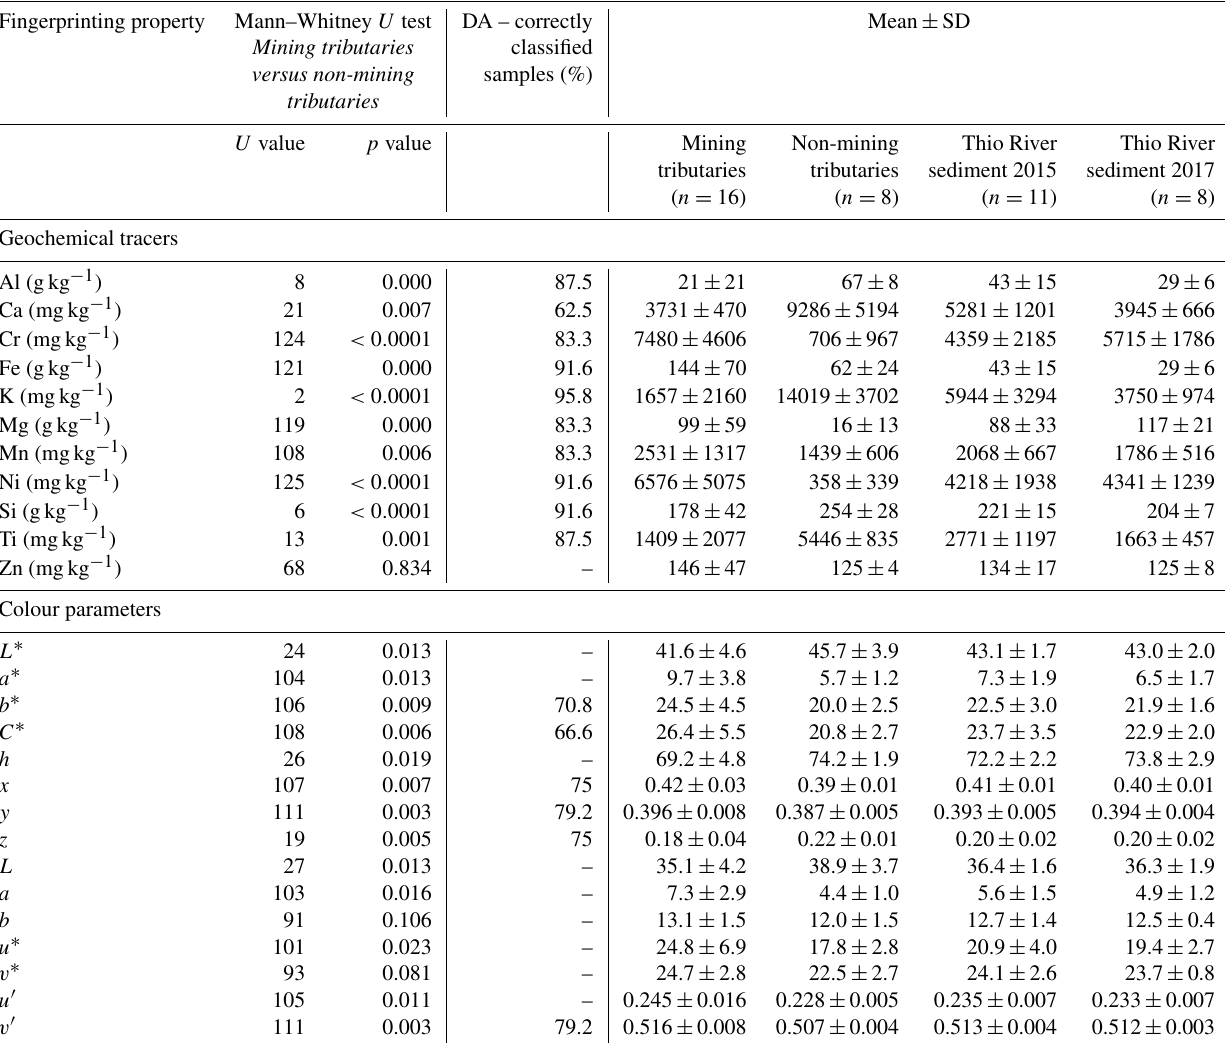
Table 2. Mean values of geochemical element contents and colour parameters in the < 63µm fraction of sediment sources and Thio River sediment (SD: standard deviation); results of Mann–Whitney U test and individual DA used to identify the potential tracers to differentiate sources supplying sediment to the Thio